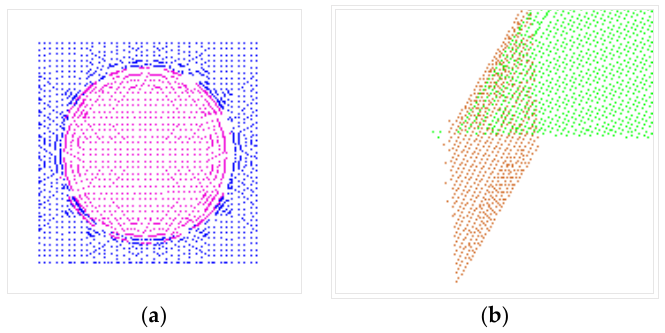
Figure 16. Display of boundary misclassification points in the support frame model: ( a ) the junction of the plane and cylindrical surface; ( b ) the junction of two planes.